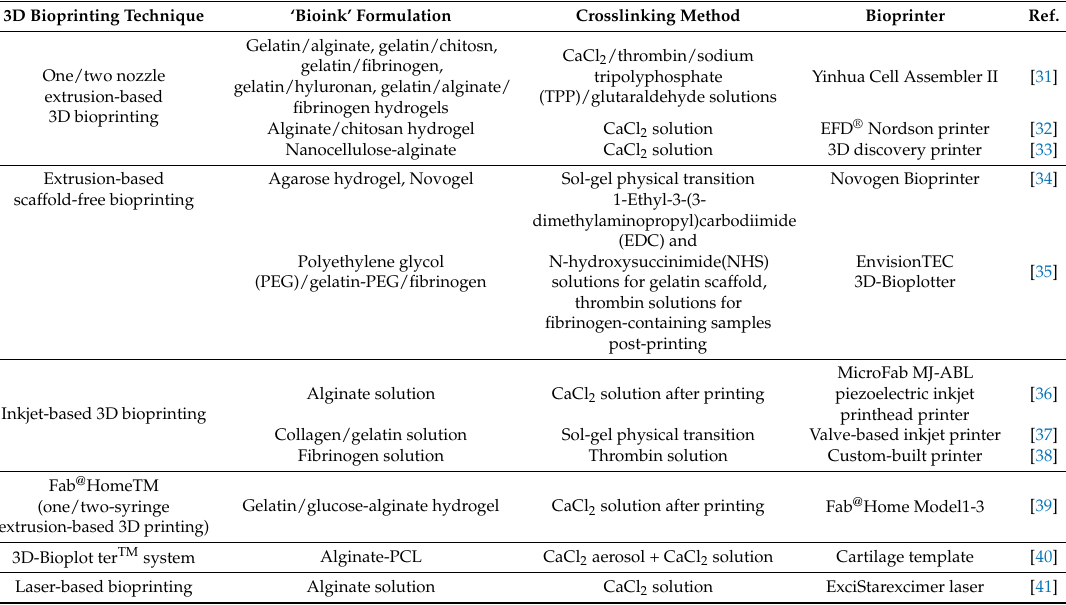
Table 1. Commercially available natural polymeric